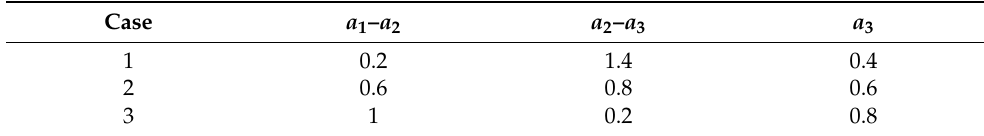
Figure 6. Validation of three-phase diffusion model, D 1 ( 0.02 ) > D 2 ( 0.005 ) , C 1 ( 1 ) > C 2 ( 0.5 ) . Table 2. The dimension parameters of the three cases.